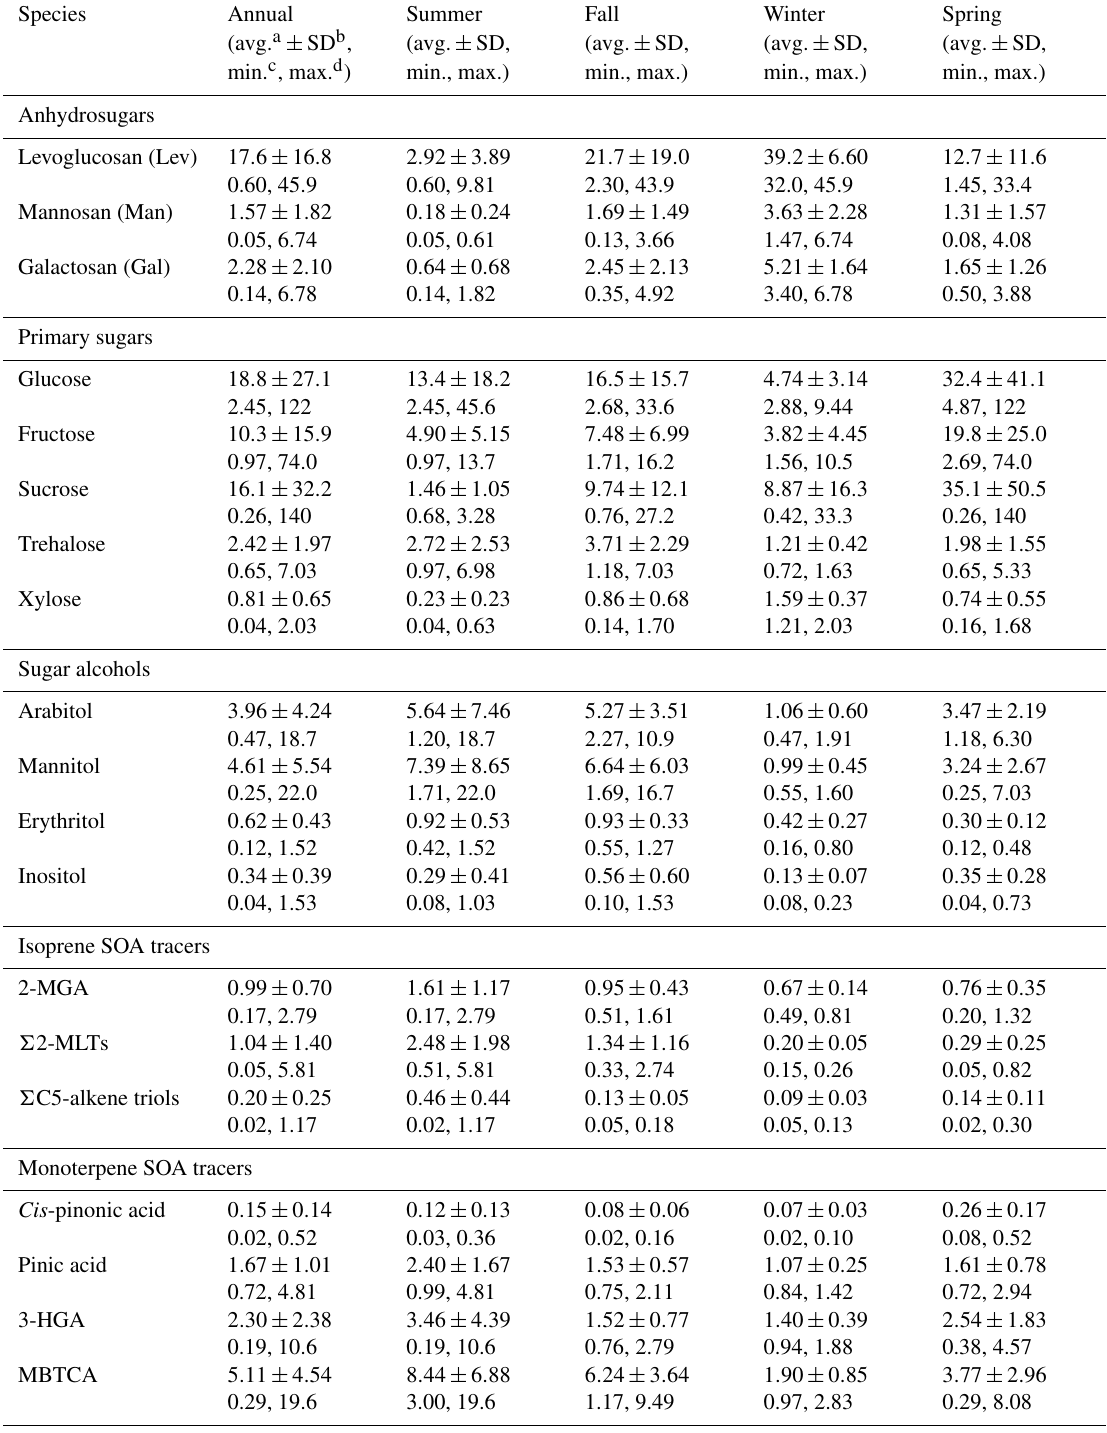
Table 1. Concentrations of identified sugar compounds and BSOA tracers (nanograms per cubic meter; hereafter ngm − 3 ) in the atmospheric aerosol samples from